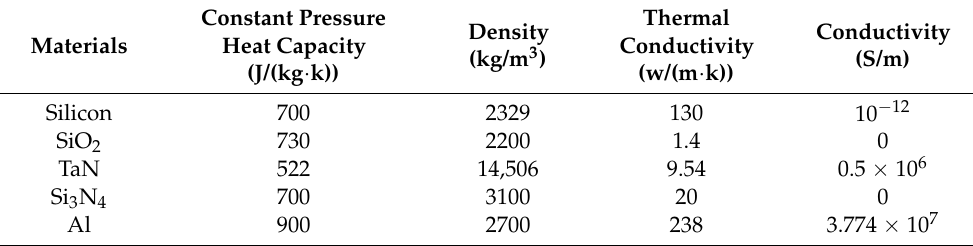
Table 2. The main parameters of the materials during the simulation, t.